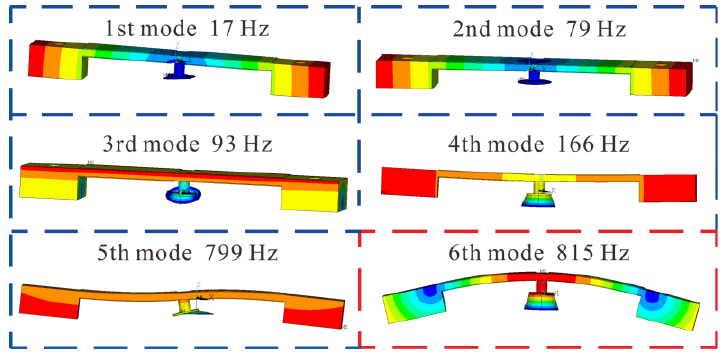
Figure 7. Actuating modes of the piezoelectric resonator with the pump chamber diaphragm.